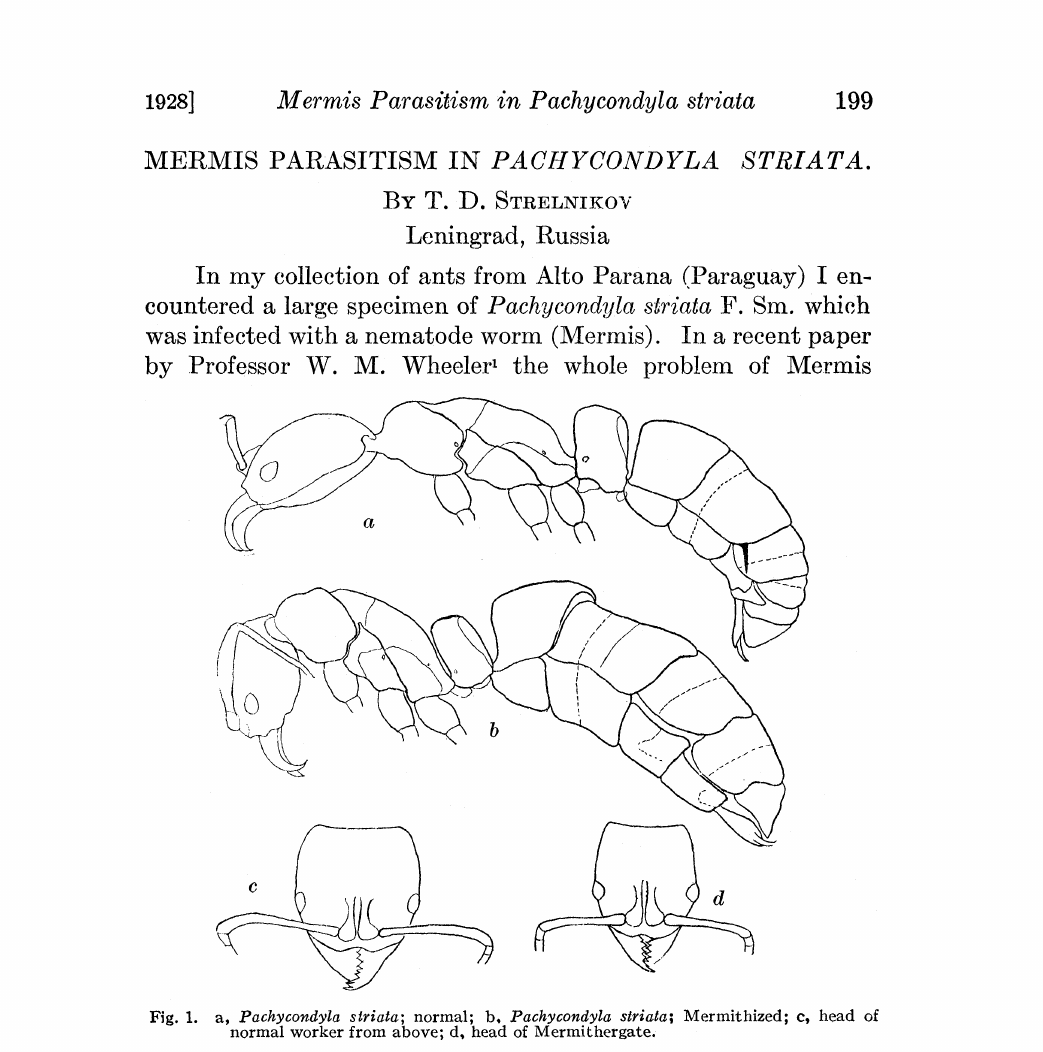
Fig. 1. a, Pachycondyla striata; normal; b, Pachycondyla striata; Mermithized; c head of normal worker from above; d, head of